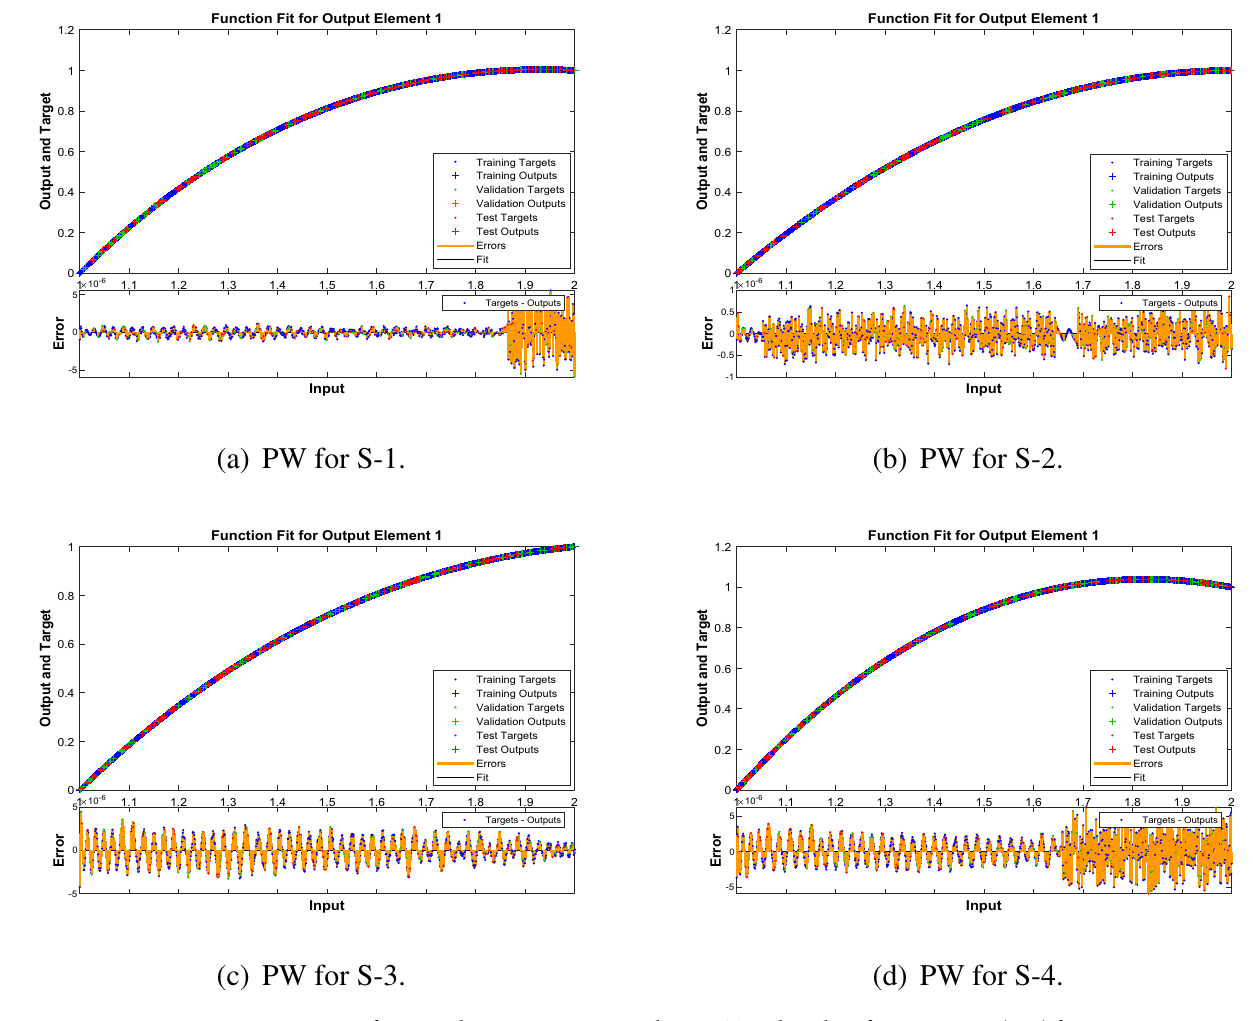
Figure 10. Reference solution comparison with LMA-TNN based performance view (PW) for case 2 in constant